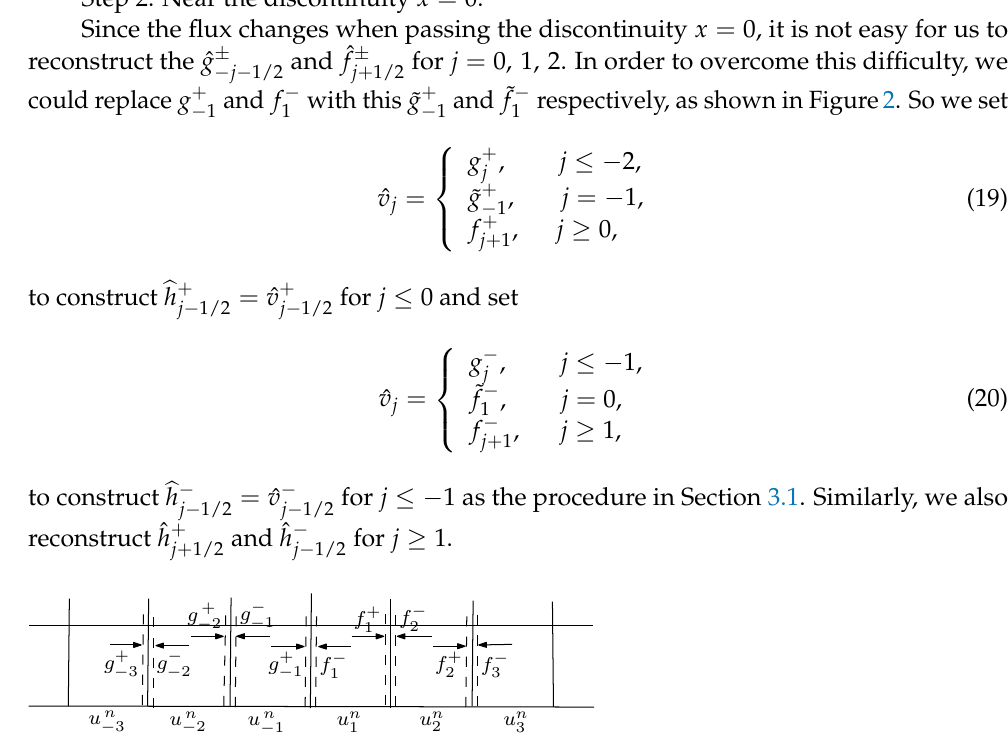
Figure 2. The flux split forms near the discontinuity x =